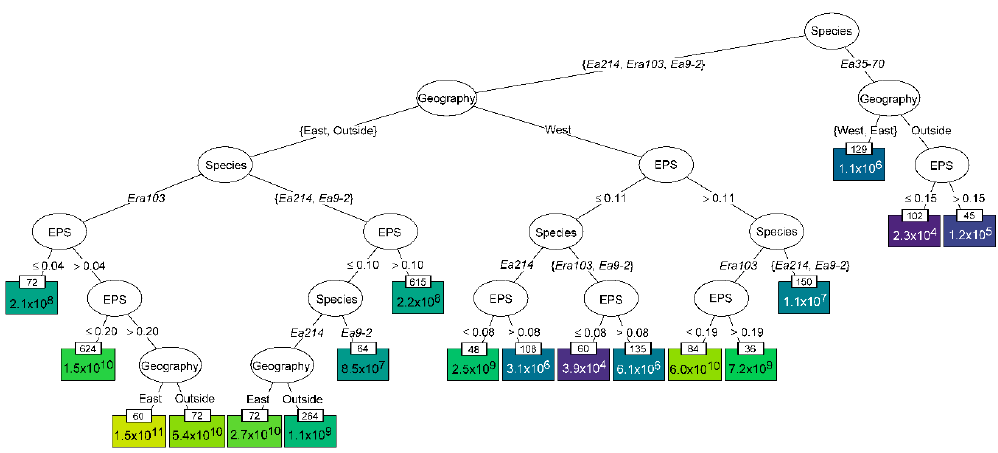
Figure 5. Conditional inference tree explaining the effect of the phage species (Species), the global location of host isolation (Geography), the relative amylovoran of the host (EPS) and genus of host isolation (Genus) on the final genomic titre of a phage. Each node is continually split based on the most significant factor. In each white oval, the deciding factor of each split is given, and the specific determinants of splitting are shown below over the branch lines. In each coloured box is the mean genomic titre (genomes/mL) for each terminal node, with the number of observations given in the small white boxes above. This was a naïve analysis with no assumptions used to influence the splitting. Full species names are truncated, numbers are rounded, and p -values (all p < 0.001) are removed for simplicity. E. pyrifoliae and E. amylovora isolated from Rubus sp. sources were excluded from this analysis.